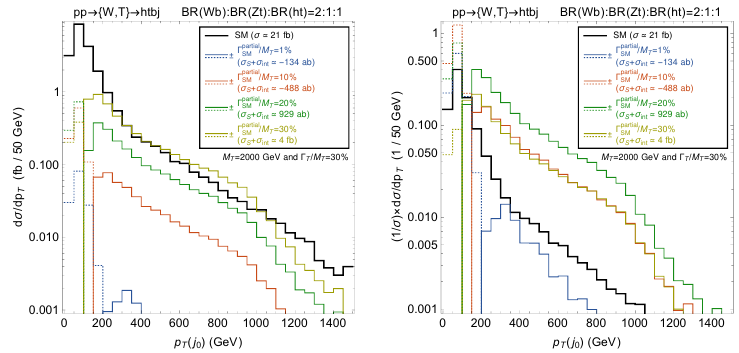
Figure 12 . Leading jet p T distribution for pp → htbj . We fix M T = 2000 GeV and Γ T /M T = 30% , and we set the VLQ couplings such that the branching ratios correspond to the singlet case and such that the sum of the partial widths for decays into SM final states corresponds to either Γ partial /M T = 1% (blue), 10% (red) and 20% (green), or saturates the total width (mustard). In SM the left panel the distributions are compared with the SM background and normalised to their respective cross section, while in the right panel we report the shapes of the